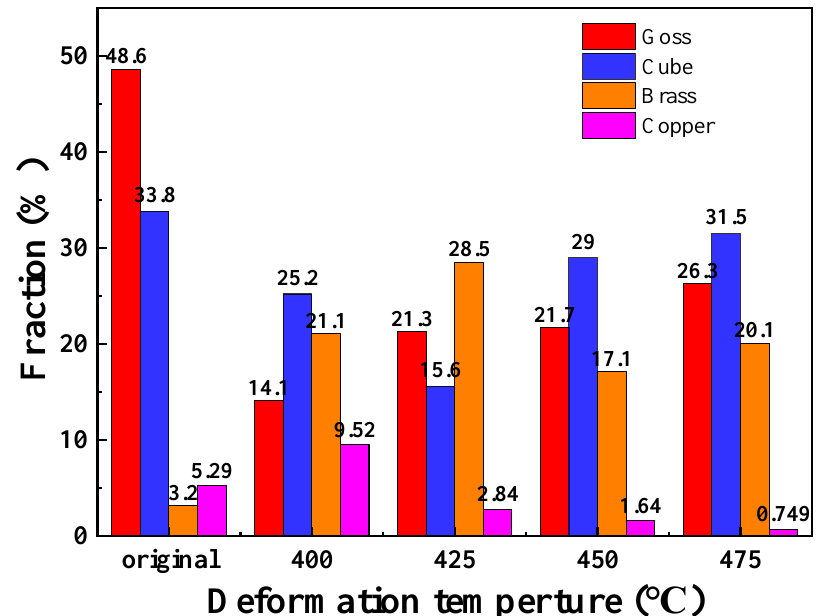
Figure 14. Texture types at different temperatures: ( a ) original; ( b ) 400 °C; ( c ) 425 °C; ( d ) 450 °C; ( e ) 475 °C.